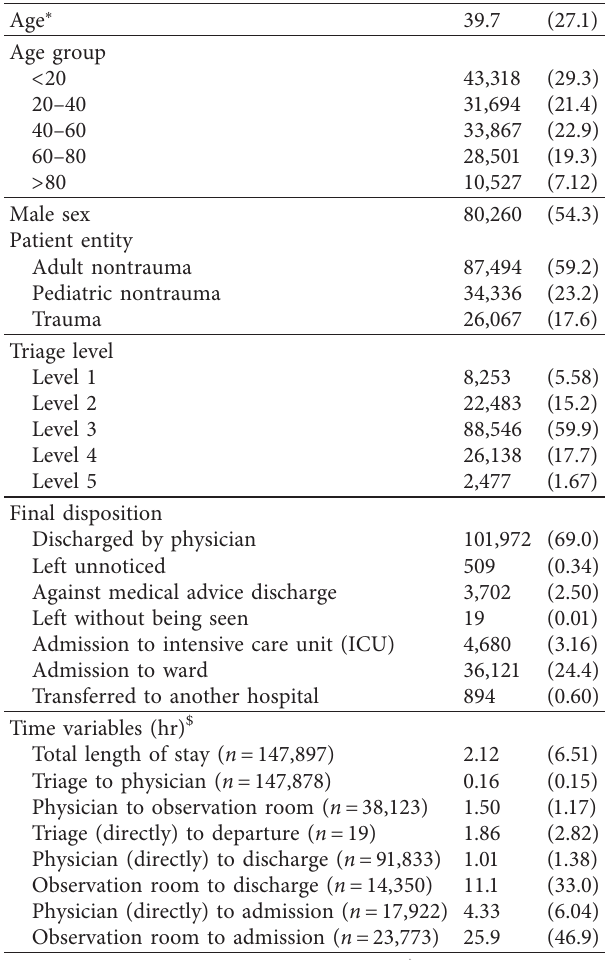
Figure 1: Five-state Markov model for the emergency department management process. The effects of covariates are also presented. An upward arrow indicates an accelerating effect on the patient movement rate, and a downward arrow indicates a decelerating effect. Table 1: Descriptive results of the patients included the study, presented as count (%) unless stated otherwise ( n �